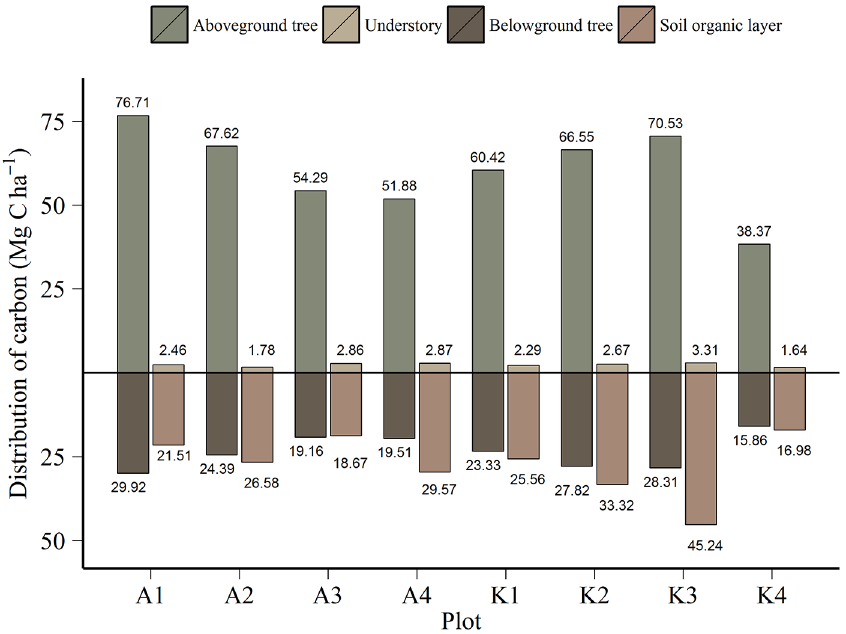
Fig 3. Size and distribution of C stocks by forest compartment. Distribution of C stocks (Mg C ha -1 ) by compartment at eight boreal forest plots. The understory compartment consists of field layer vegetation, mosses and